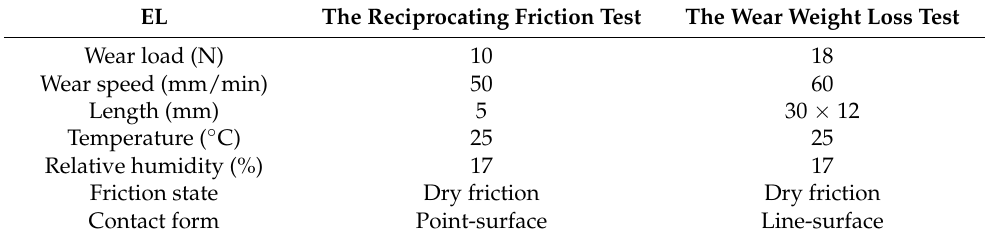
Figure 2. ( a ) The surface performance tester MFT-4000, ( b ) the schematic diagram of the experimental sample, ( c ) the wear tester NUS-ISO3, ( d ) the schematic diagram of the experimental sample. Table 2. The wear test parameters.